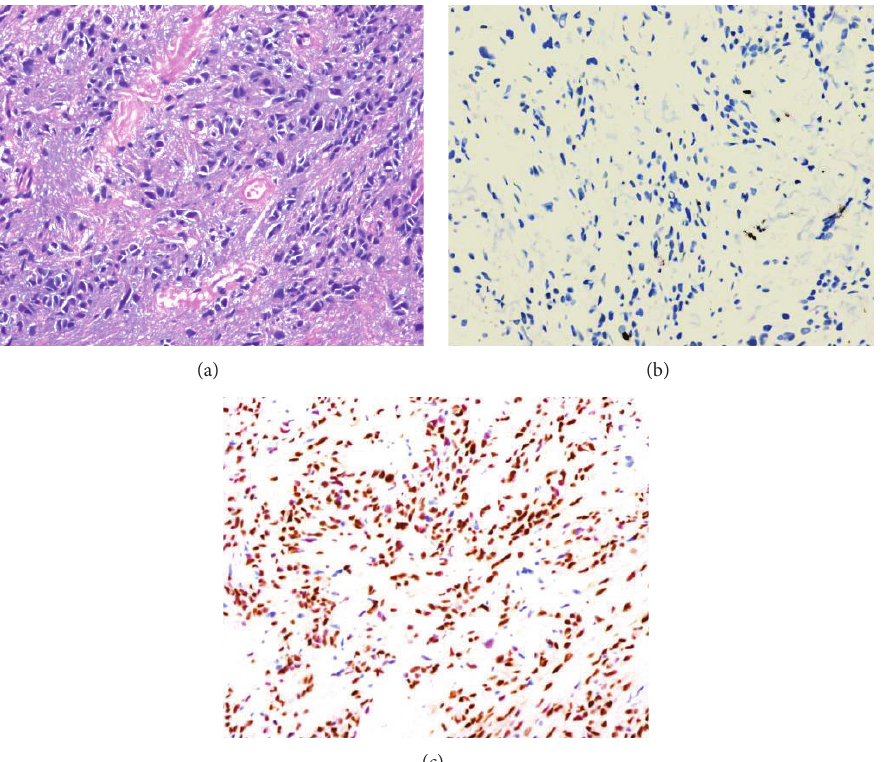
Figure 4: Pathologic findings of the breast lesions. (a) Overall appearance: tumor cells arranged in single file reminiscent of invasive lobular carcinoma (H&E × 200). (b) Negative for pankeratin (IHC × 100). (c) Estrogen receptor positivity (IHC ×